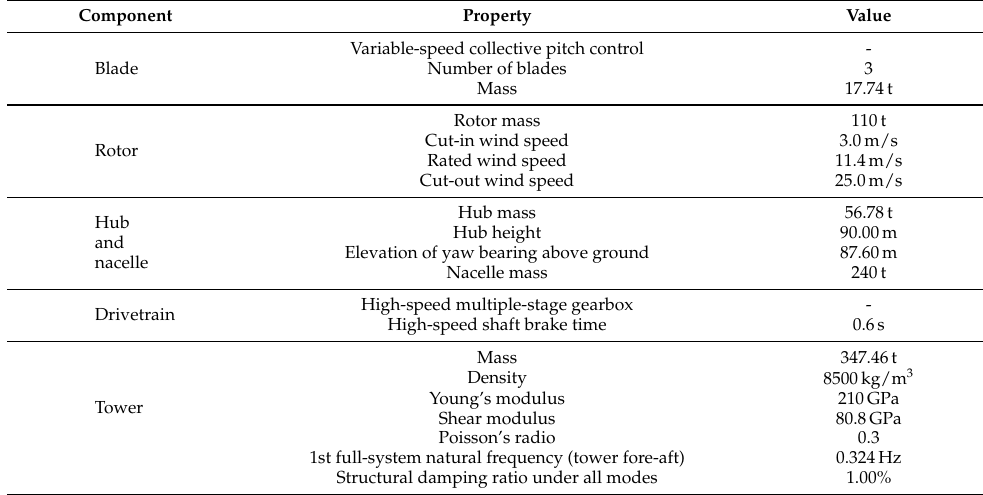
Table A1. Overview of NREL 5MW baseline wind